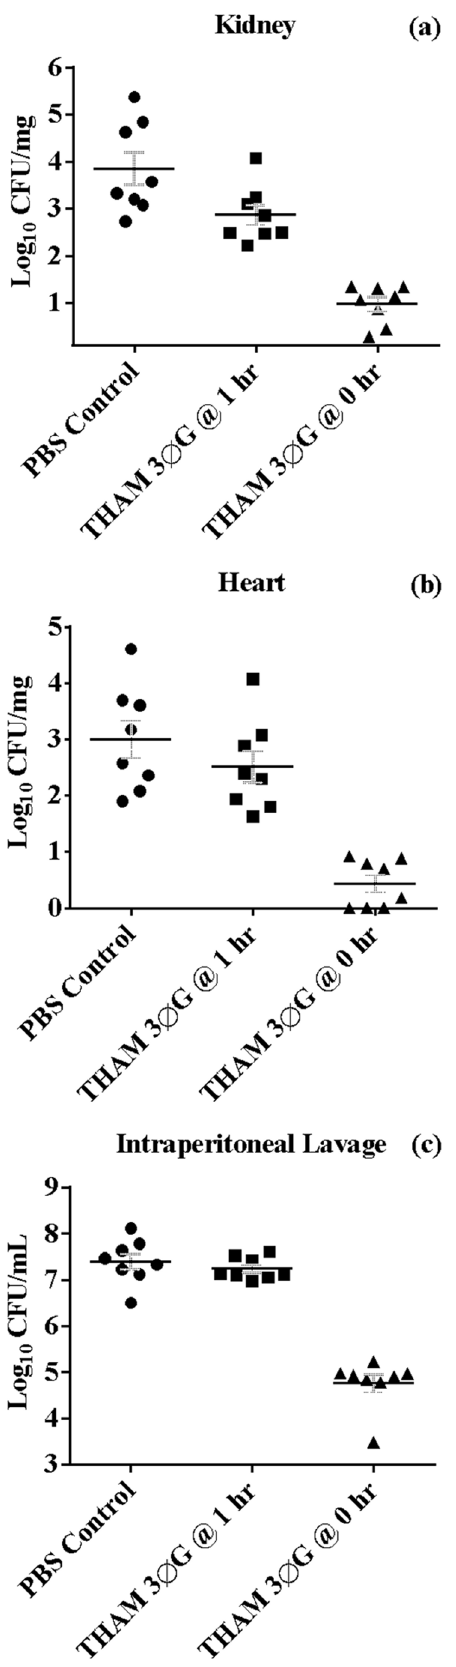
Figure 4. THAM-3 W G reduces MRSA burden in vivo during peritonitis. Mice were treated with PBS control or with THAM trisphenylguanide immediately after or at one hour post intraperitoneal infection. Bacterial burden was evaluated in the kidney (A) and heart (B); localized infection was assessed with peritoneal lavage fluid (C). The horizontal bar is the mean of the eight mice per treatment group; error bars represent standard error of the mean. Reductions in burden were significant (t-test) in kidneys for both the 1 hr (p=0.028) and 0 hr (p=2 6 10 2 6 ) treatments. Reductions were significant in the heart (p=4 6 10 2 5 ) and IP lavage (p=6 6 10 2 8 ) only for the 0 hr